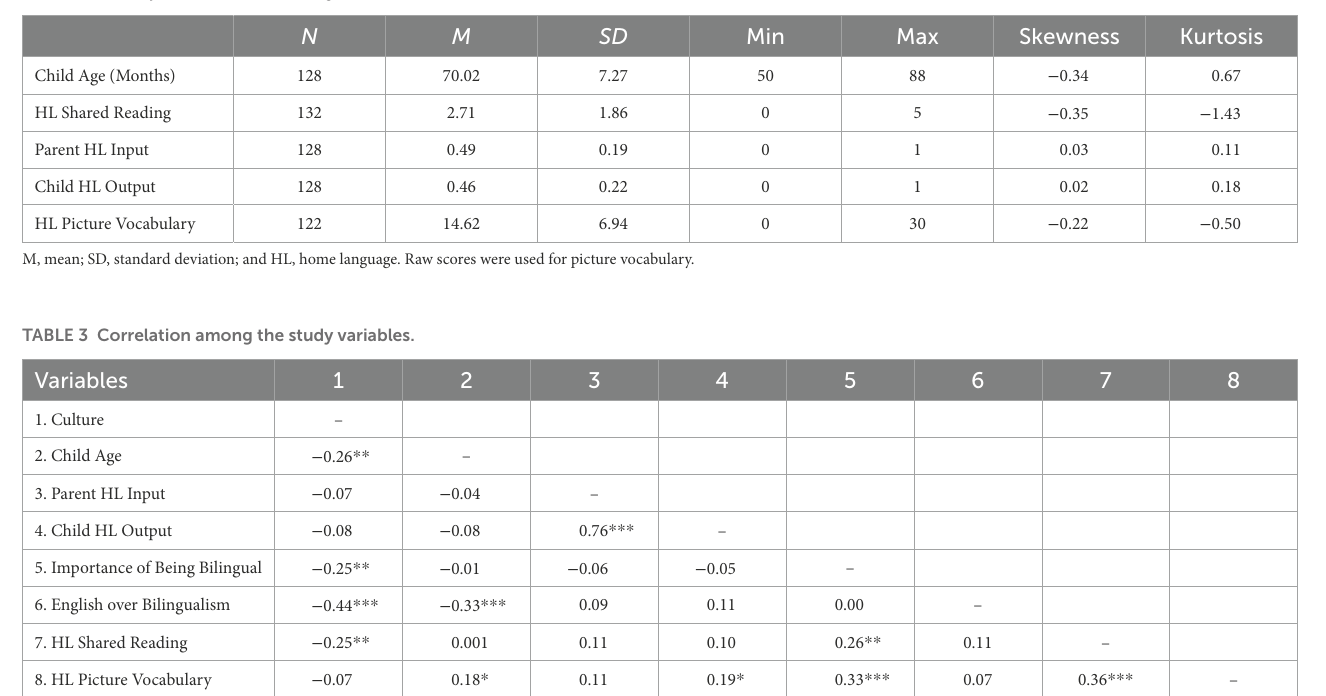
TABLE 2 Descriptive statistics of study variables.